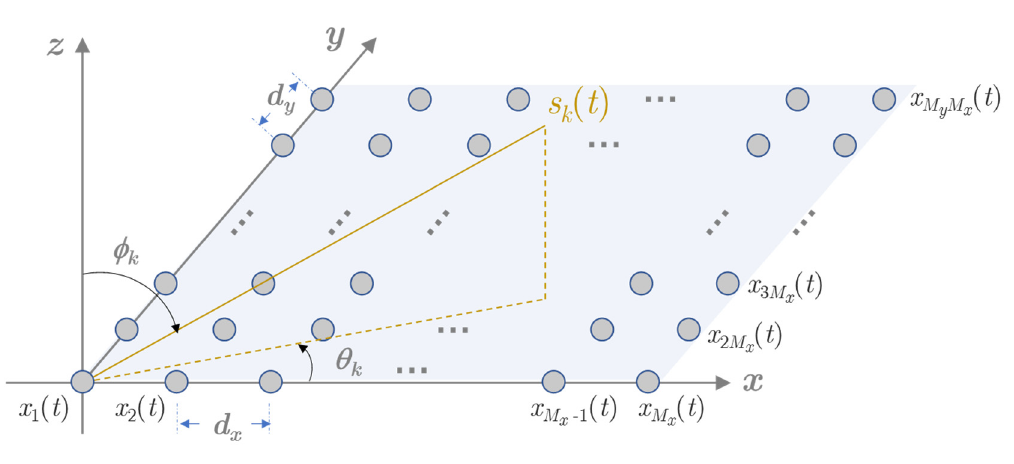
Figure 1. The structure of a uniform rectangular array (URA) with M elements.